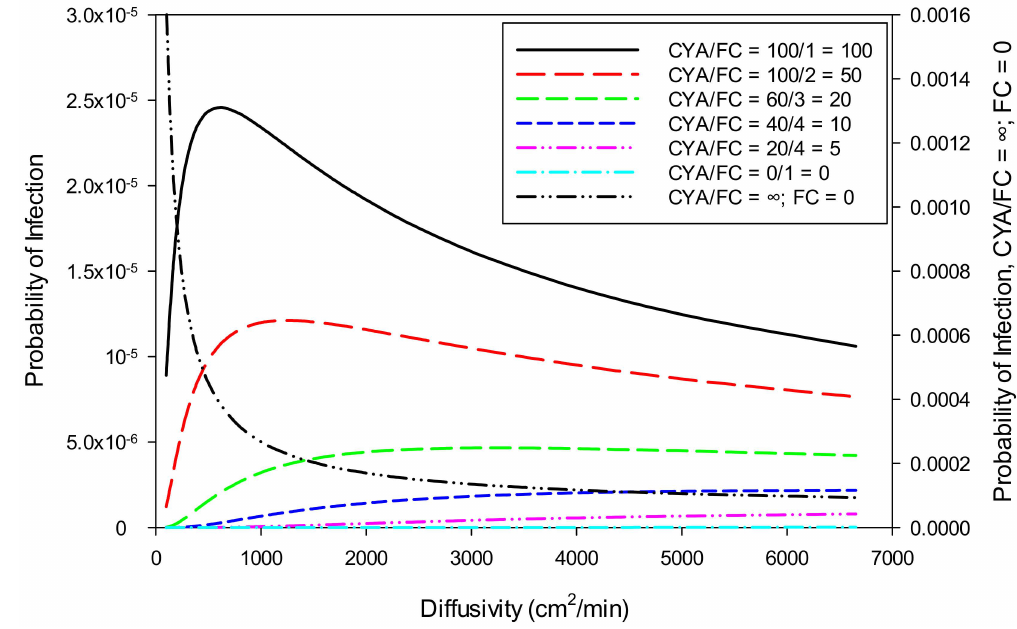
Figure 6. Sensitivity of probability of infection from E. coli to di ff usivity at various ratios of CYA /